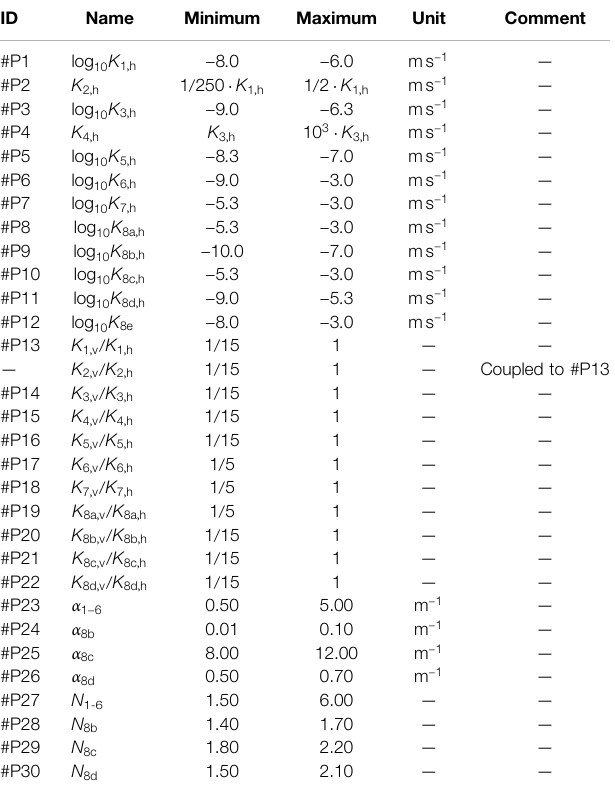
TABLE 1 | Prior parameter ranges of random material properties of hydrostratigraphic units considered in the